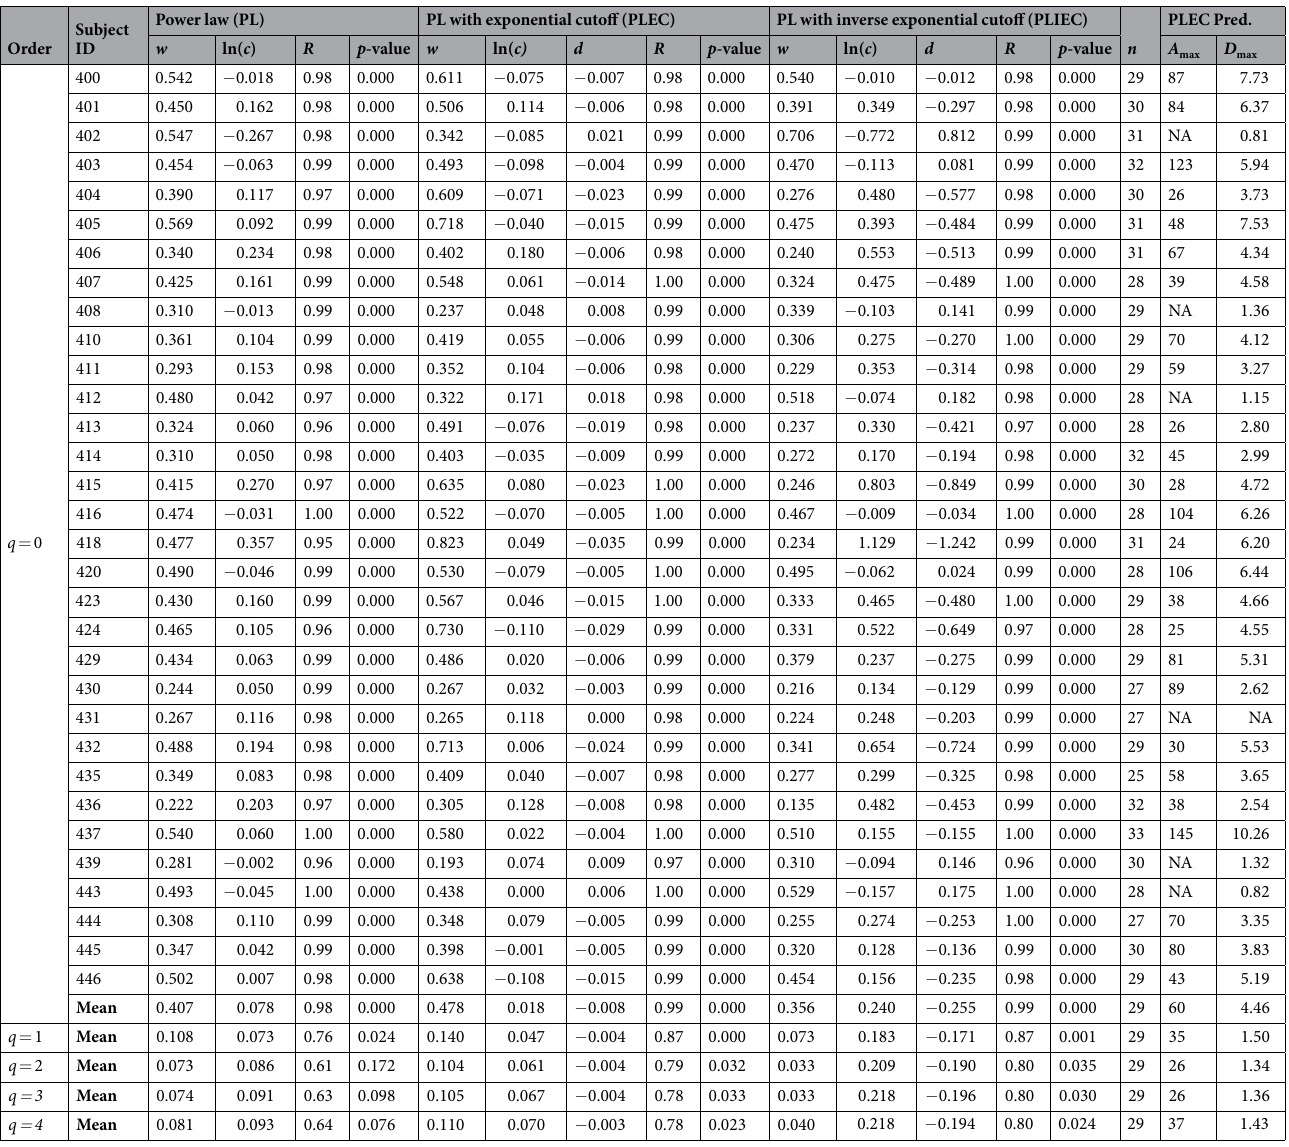
Table 2. The Beta-Diversity Time Relationship ( B DTR) models for the individuals in the 32-healthy cohort * . * Only the B DTR models for q = 0 and the mean parameters for the whole cohort for q = 1–4 are listed here; to save page space the full results for q = 2–4 are presented in Suppl. Table S1B.